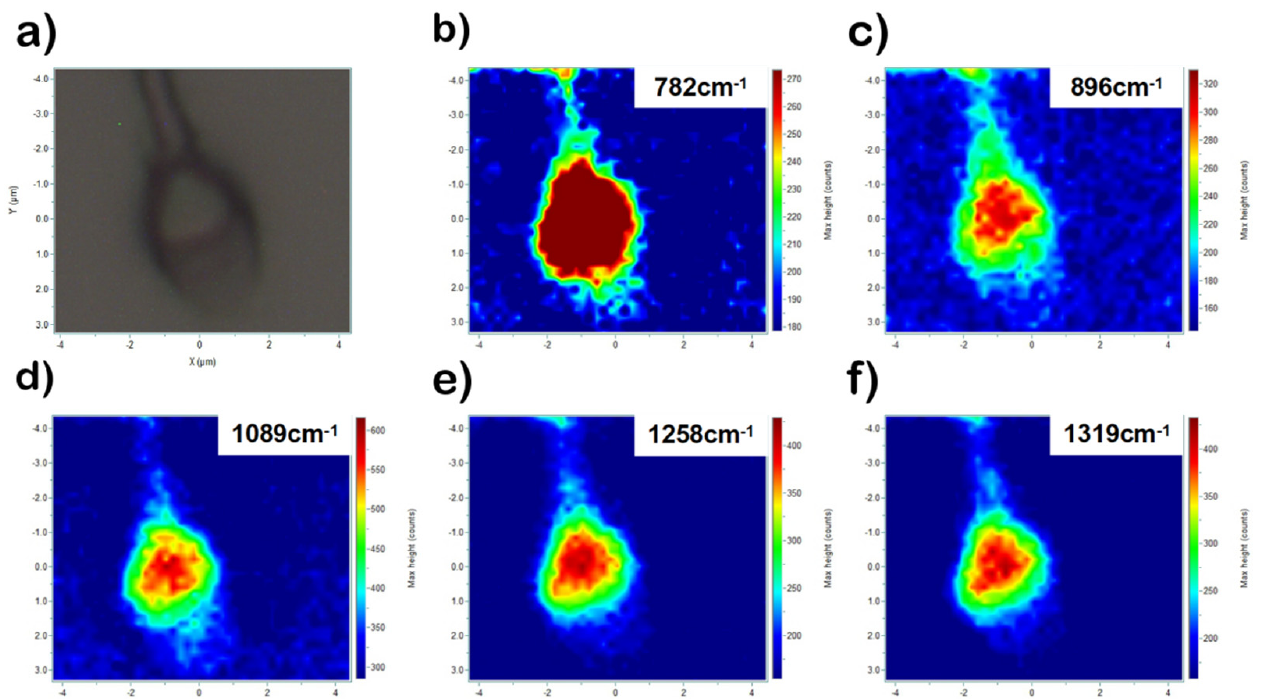
Figure 3. ( a ) Typical morphology of sperm cell head region under a light microscope; ( b – f ) Corre- sponding Raman mapping of sperm head region using band intensities at 782, 896, 1089, 1258, and 1319 cm − 1 , respectively.